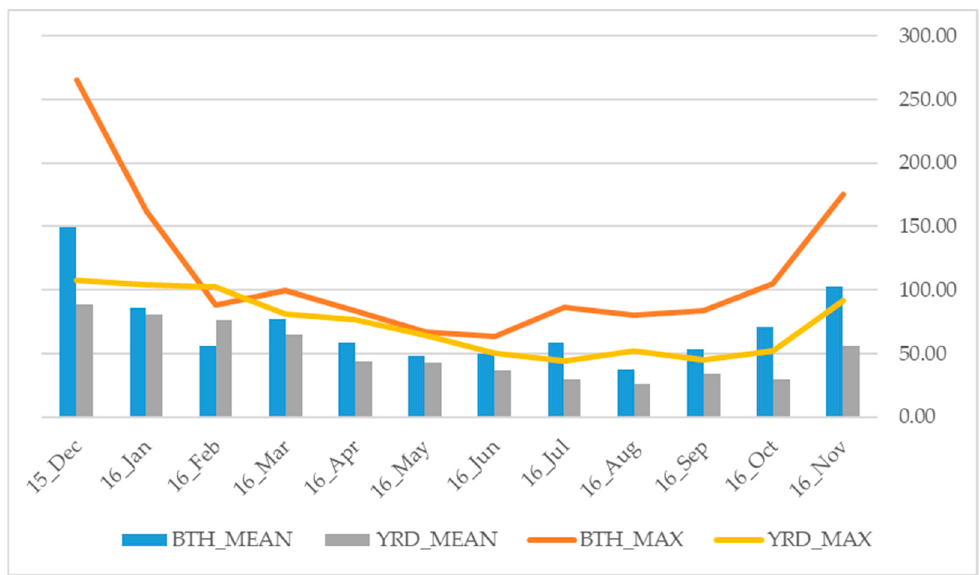
Figure 6. The estimated monthly PM 2.5 concentrations in the YRD and BTH regions. Table 6. Estimated seasonal and annual PM 2.5 concentrations in the YRD and BTH